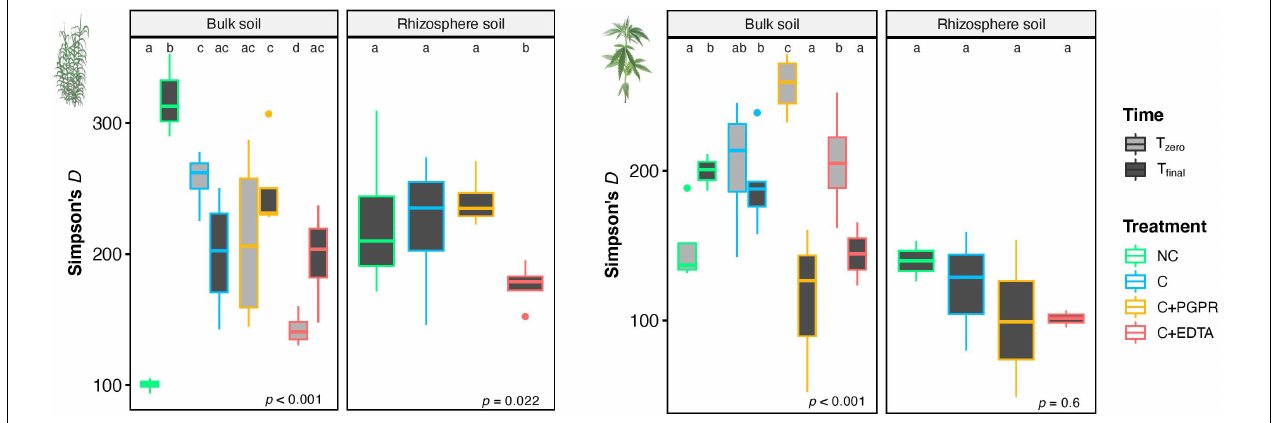
FIGURE 6 | Mean values of Simpson’s index ( D ) in BS and RS of giant reed (Left) and hemp (Right) as affected by treatments and sampling time ( T z , time zero sampling; T f , at the end of experiment). Different letters denote statistically different (Tukey’s test, P = 0.05) D -values among treatment in BS and RS for single